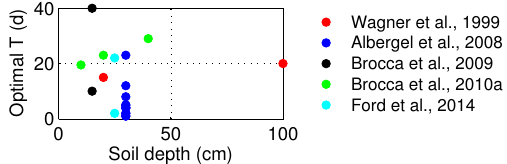
Figure 9. Optimal T parameter against soil depth found in previous studies.